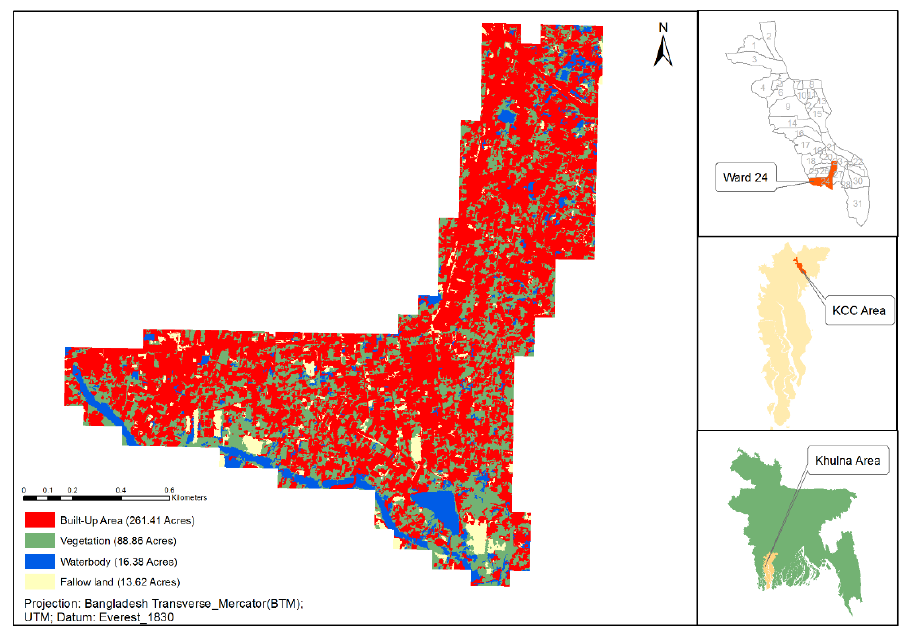
Figure 3. Knowledge-based Image Classification Process Flow.